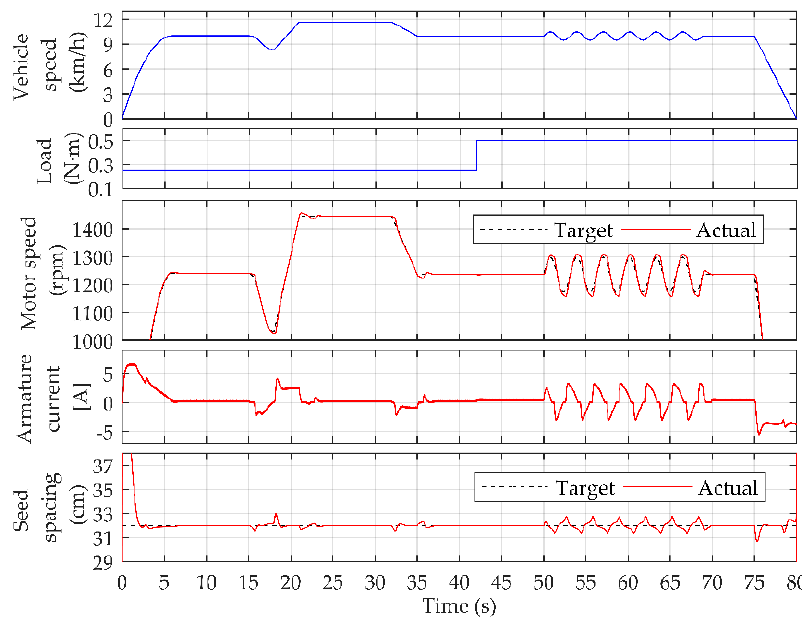
Figure 16. Simulation results for seed spacing.